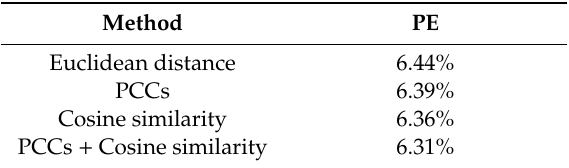
Table 3. Statistical error of different similar days selection methods.